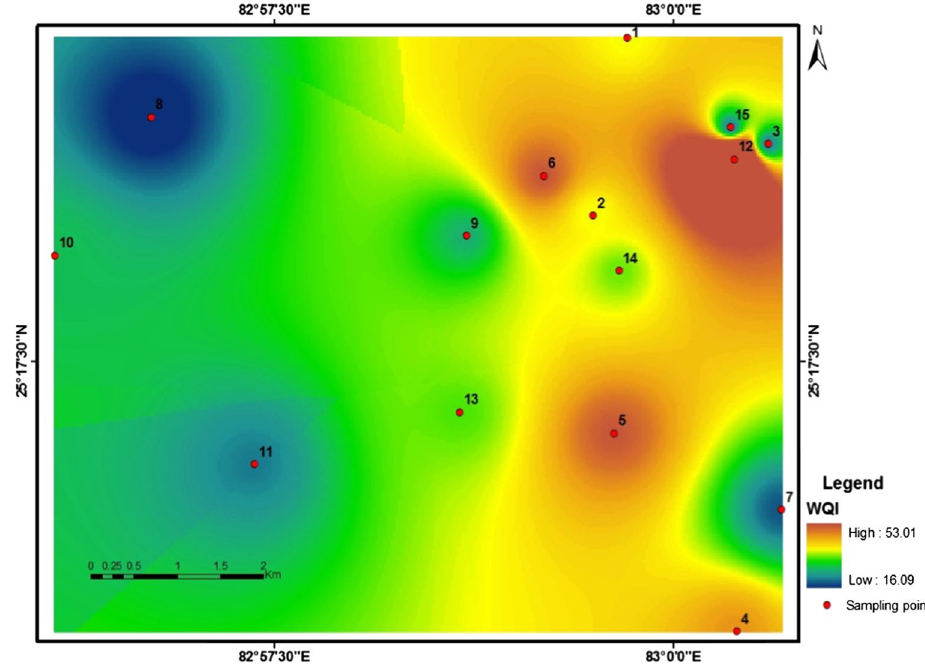
Fig. 5 Spatial distribution